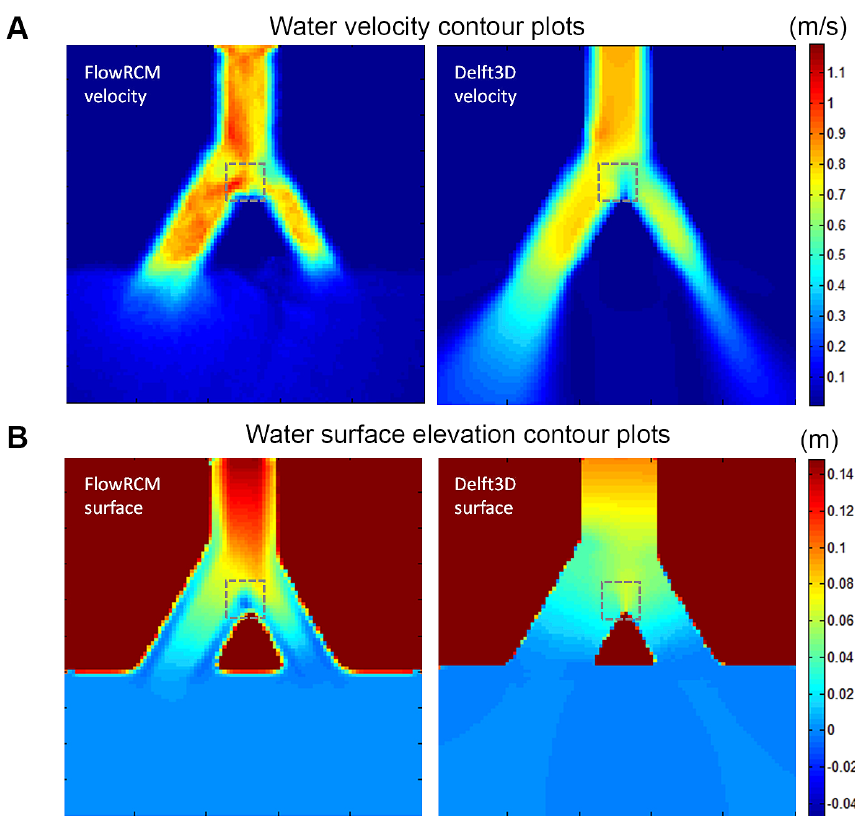
Figure 9. Results from run C3: (a) water velocity and (b) water surface elevation. FlowRCM and Delft3D behave differently at the upstream side of the triangle island (marked by the dashed gray square): while Delft3D exhibits a low velocity zone with a high water surface elevation, FlowRCM exhibits a high velocity zone and a low water surface